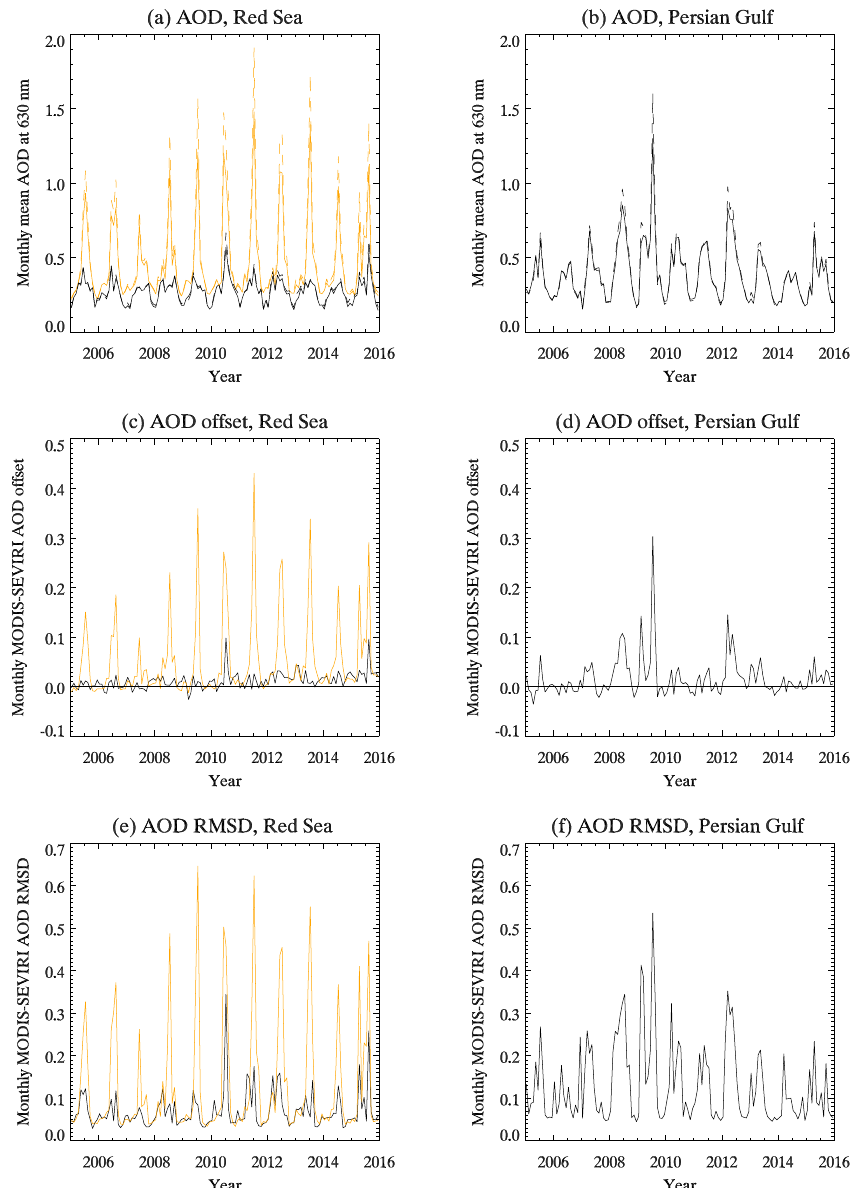
Figure 7. Time series of monthly average MODIS/SEVIRI AOD statistics over the Red Sea (left column: a , c , e ) and the Persian Gulf (right column: b , d , f ). (a, b) Average AOD at 630nm: solid lines represent SEVIRI; dashed lines represent MODIS; in the Red Sea, black indicates the northern half of the Sea and orange represents the south. (c, d) MODIS-SEVIRI offset. (e, f) MODIS-SEVIRI